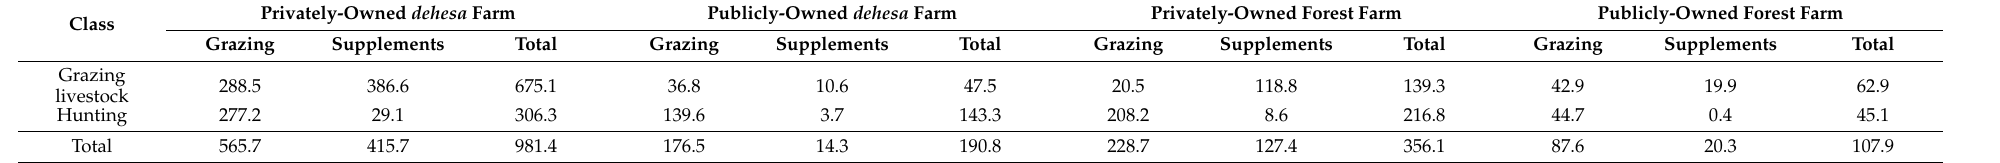
Table 2. Grazed fodder consumption of case-study large dehesa and forest farms in Andalusia (2010: FU/ha *).